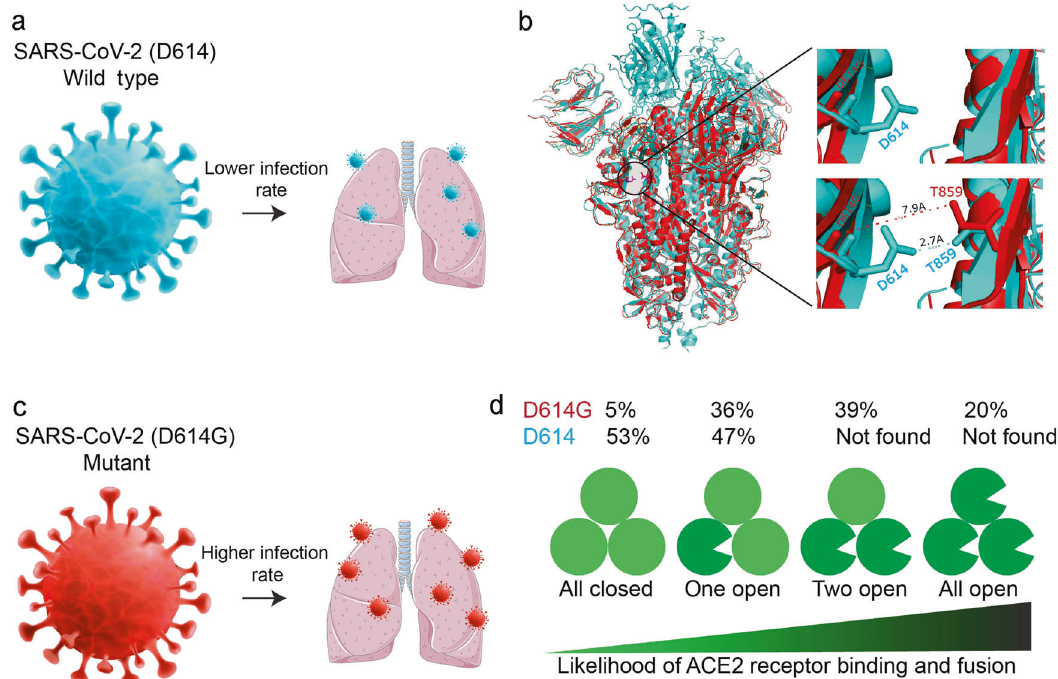
Fig. 1 The structure and infectivity of the wild-type (D614) and mutant (D614G) spike proteins. a An illustration of SARS-CoV-2 infecting human lungs. b Cryo-EM structure of the spike proteins (PDB: 6vsb and 6xs6), the black circle in the center indicates the position of the amino acid D614 and/or D614G. The structures of the wild-type (cyan) and mutant (red) spike proteins were superimposed, which show an overall similar architecture between them with an rmsd of 0.77 Å. The fi rst inset (upper panel) shows residues D614 in cyan and D614G in red. The second inset (lower panel) shows residue D614 forming an H-bond with T859 of the adjacent protomer in the wild-type spike protein (PDB: 6vsb). The D614G mutation causes an increase in the distance between D614G and T859, which results in elimination of the H-bond formation between them (PDB: 6XS6). c An illustration of mutant SARS-CoV-2 infecting human lungs. d The D614G spike trimer is comparatively more fl exible and adopts at least four major conformations in contrast to two observed for the D614 protein trimer. The D614G mutation causes spike protein trimer to occupy more open conformations, which increases the probability of ACE2 receptor binding and the virion membrane- target cell fusion. Circles in light green indicate close conformation of the protomer and illustrations of Pac-Man in the dark green indicate open conformation of the protomer. The fi gures were prepared using Pymol and Adobe